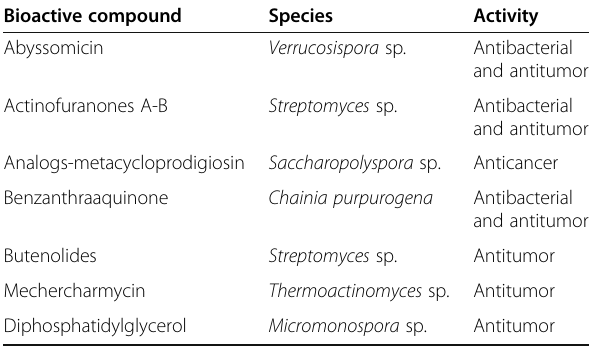
Table 4 List of the bioactive compounds derived from actinobacteria showed antibacterial and antitumor activities [41]